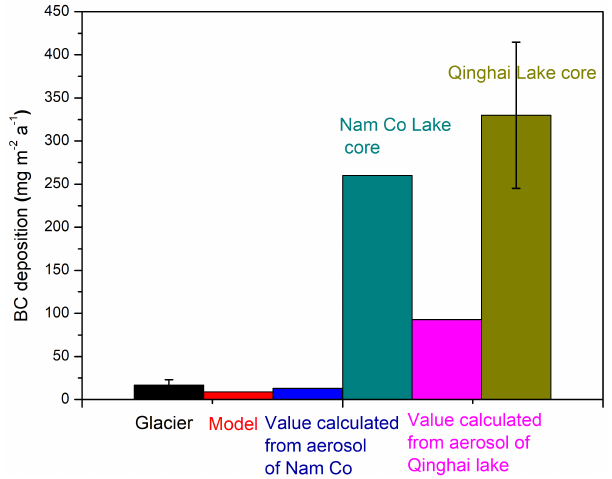
Figure 6. Comparison of atmospheric BC deposition rates derived from the glacial region, models, lake cores and values calculated from BC concentrations in the aerosols of the